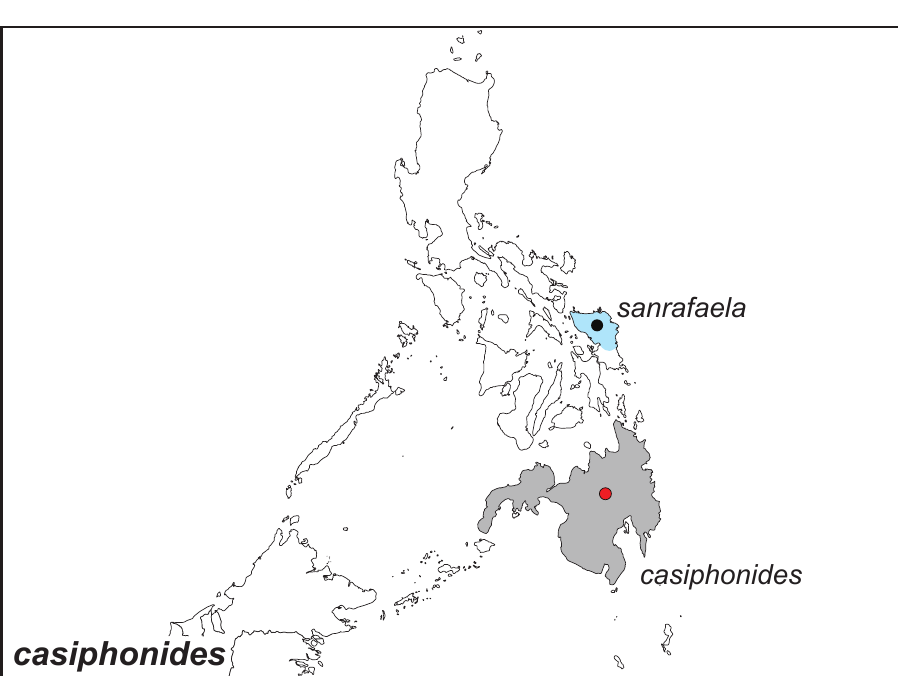
Figure 56. Distribution map of Elymnias casiphonides